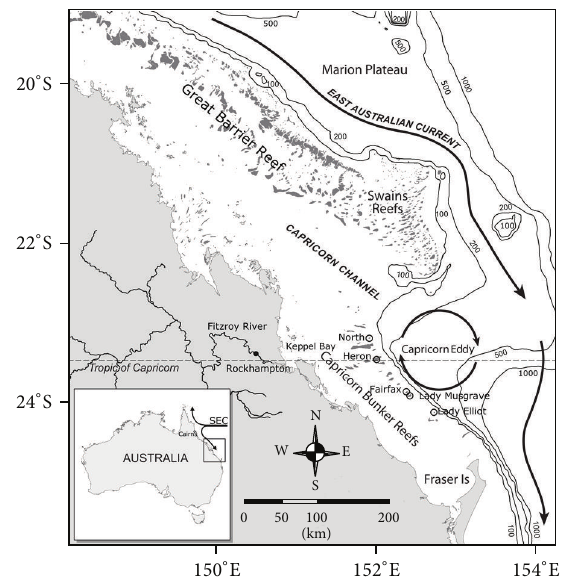
Figure 1: The Mackay/Capricorn Section of the GBR showing the location of the Swain Reefs and Capricorn-Bunker Reefs in relation to the coast. Isobaths represent depth in meters and show the edge of the continental shelf. Arrows show the general position of the South Equatorial Current and the East Australian Current and Capricorn Eddy. The mouth of the Fitzroy River is located southeast of Rockhampton and discharges into Keppel